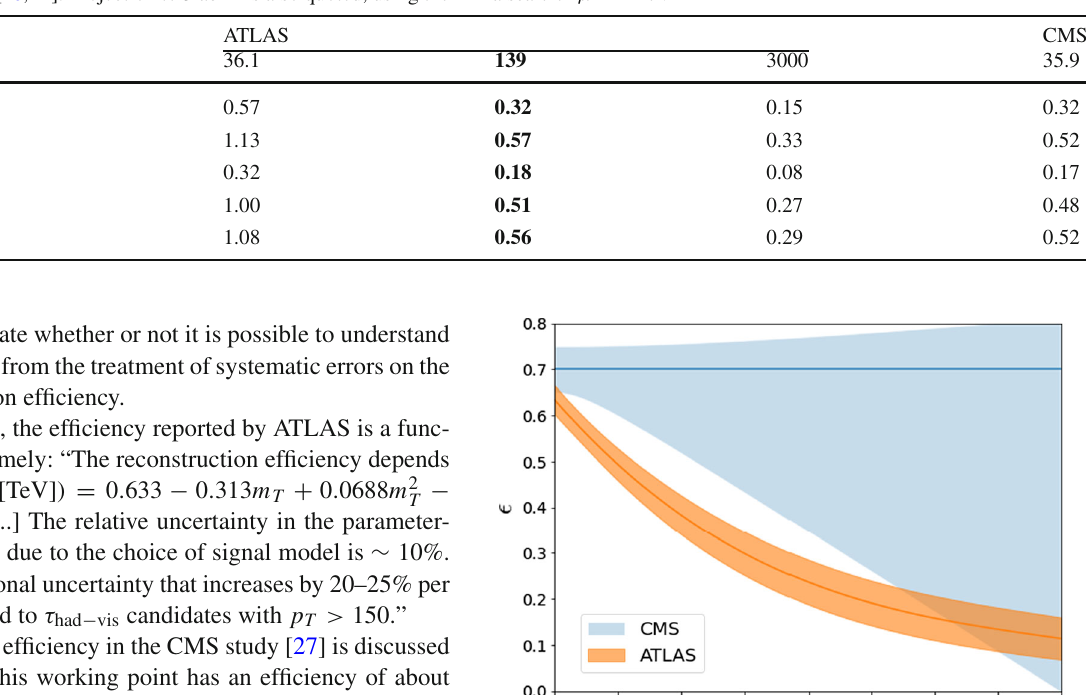
method described in the text. The above values are obtained by using only the central value of the τ reconstruction efficiency, (cid:12)(τ) . The last = + 4 g = − 4 g two lines correspond respectively to g S T and g S L T at L a scale of μ (cid:9) 1 TeV